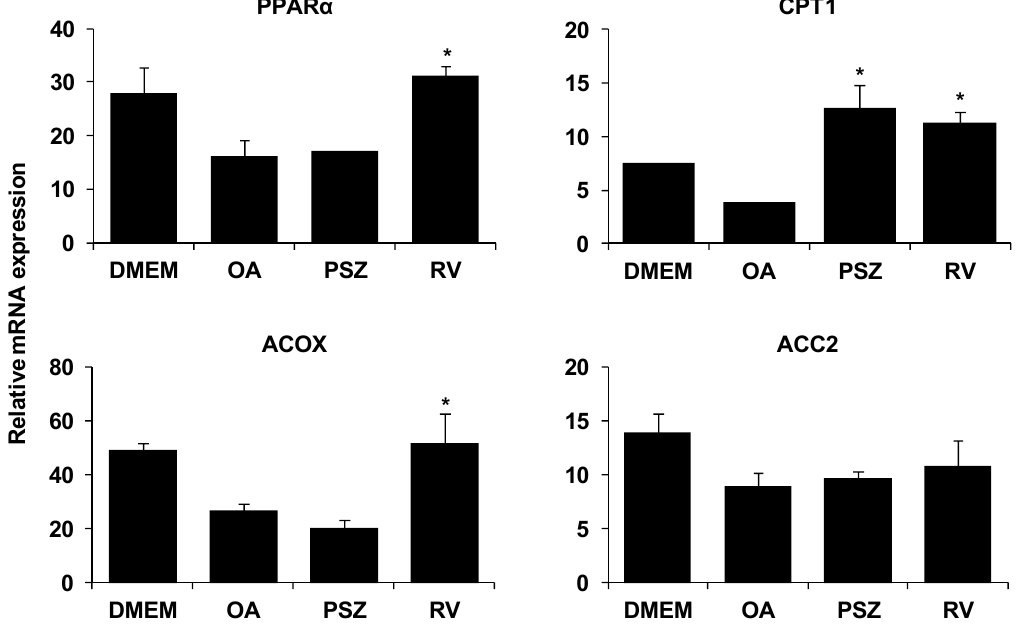
Figure 4. Effects of Pinus densiflora Sieb. et Zucc. (PSZ) on expression of hepatic lipolysis genesin HepG2 cells stimulated with oleic acid (OA). HepG2 cells were treated with 100 μ g/mL PSZand OA. After treatment for 24 h, RNA was isolated and reverse-transcribed for RT-PCR analyses using the primers described in Table 1. Results are the mean ± SEM from three independent experiments. * p < 0.05 compared with the OA group. DMEM, control group; OA, oleic acid-treated group; PSZ, OA + Pinus densiflora Sieb. et Zucc.-treated group treated group; RV, OA + resveratrol-treated group.